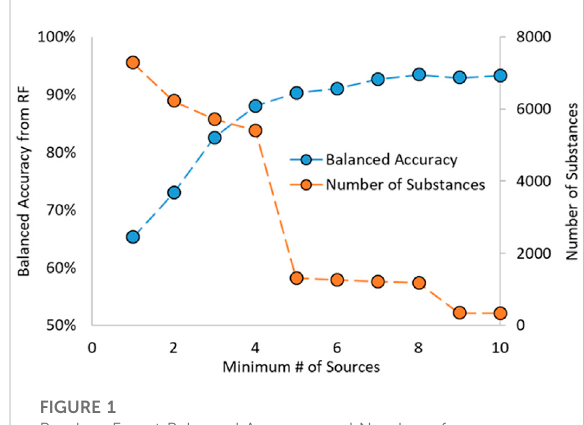
FIGURE 1 Random Forest Balanced Accuracy and Number of Substances as a function of Minimum Number of